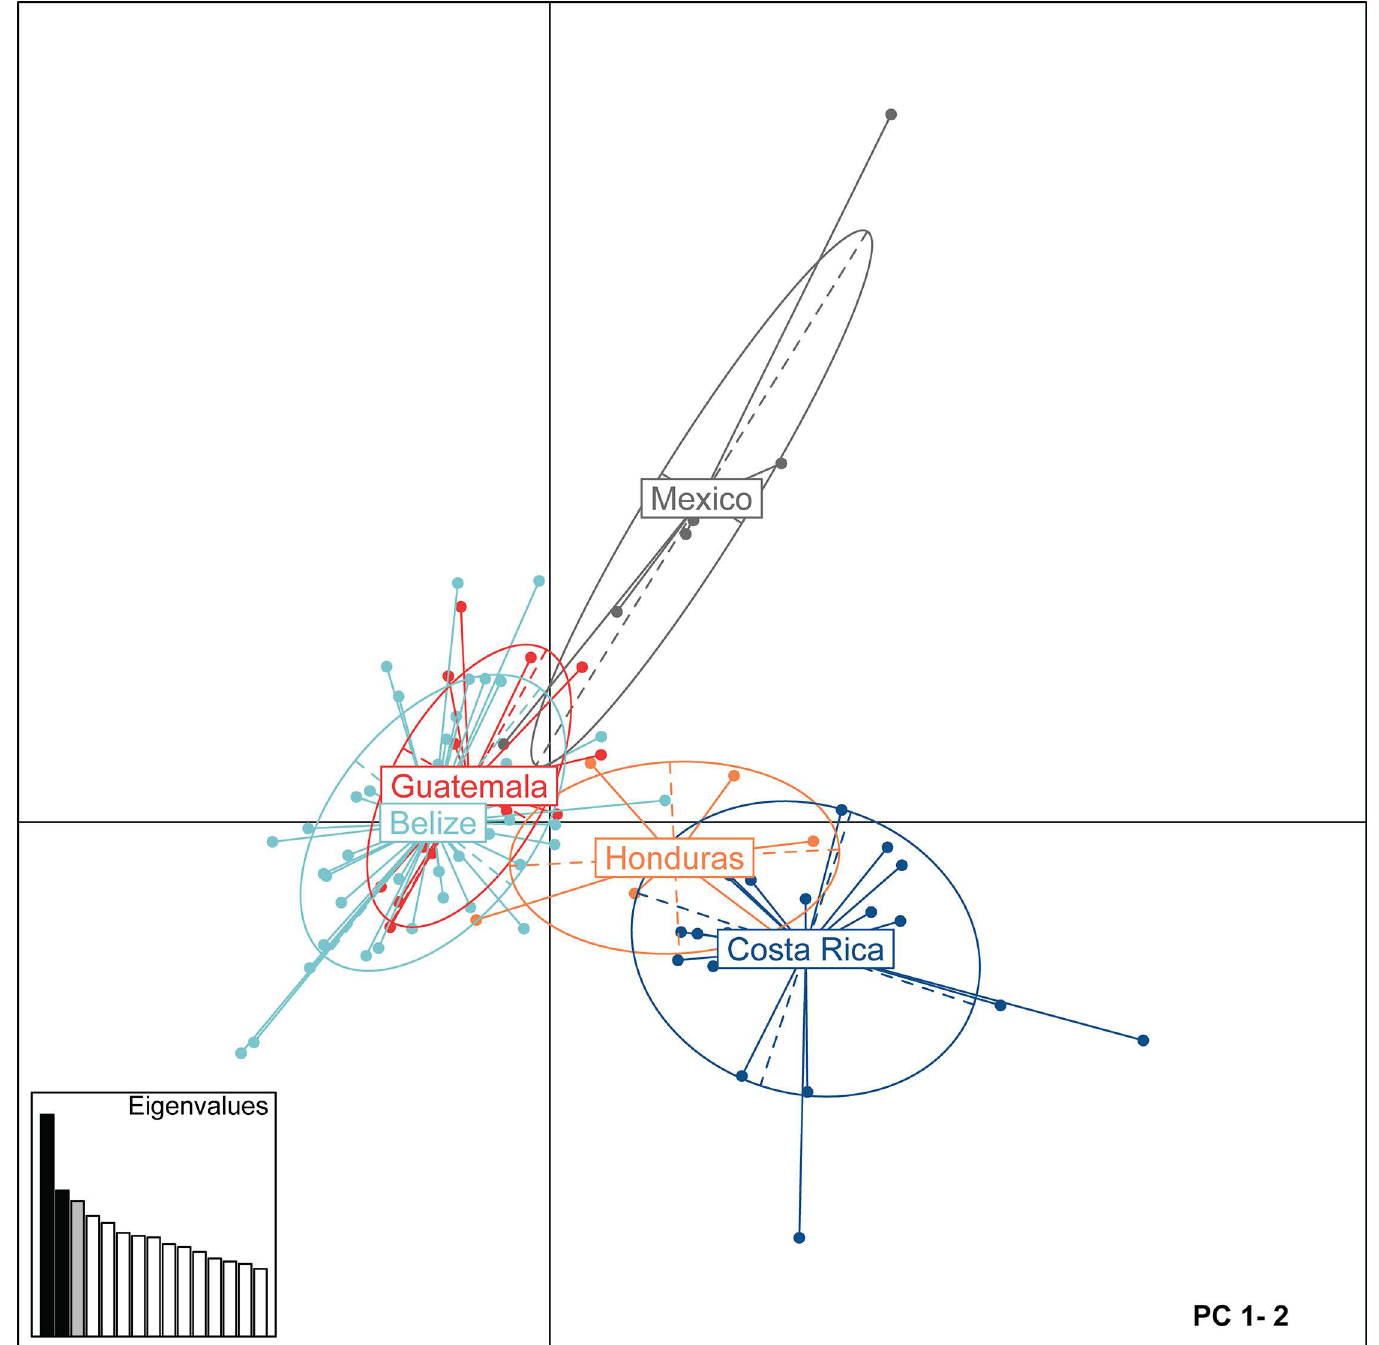
Fig 5. Principal component analysis (PCA) based on Mesoamerican jaguar genotypes. Scatterplot visualizes the first two principalcomponents. Points represent individualgenotypes, and geographicalgroups of jaguarssampled across five Mesoamerican countries (Belize, Costa Rica, Guatemala, Honduras,Mexico) are 95% inertia ellipses in different colors. Inserted barchart shows eigenvalues with corresponding components in dark grey. PC, principalcomponent.